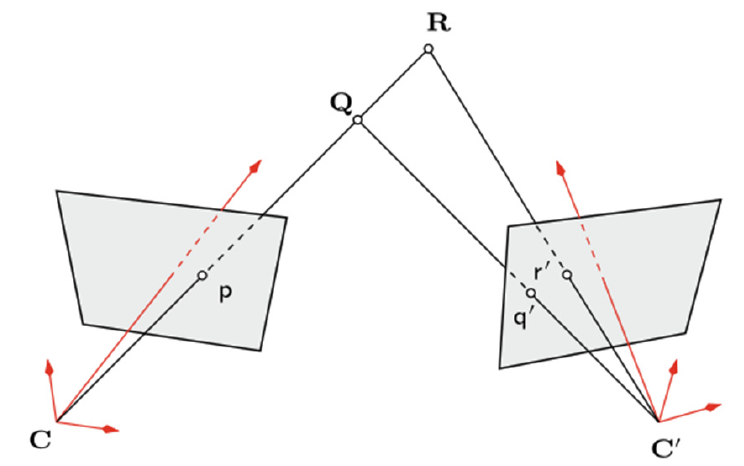
Figure 4. Sketches of correlation match: ( a ) reference image; ( b ) deformed image.